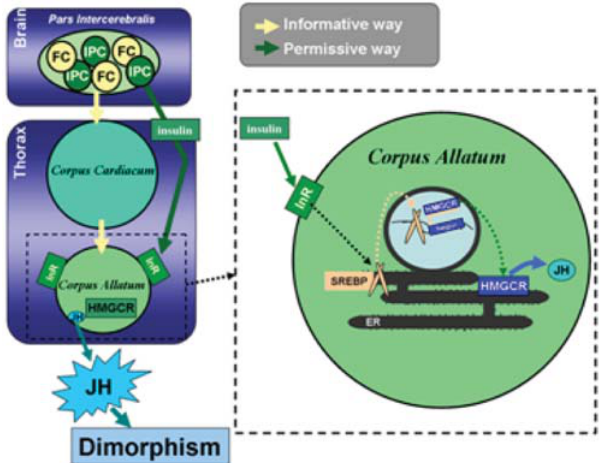
Figure 8. Model of the insulin pathway regulating the expression of the HMGCR in the corpus allatum. We hypothesize that the two different populations of cells, the Insulin Producing Cells (IPCs) and the feminising cells (FCs), located in the pars intercerebralis control, by two distinct ways, the JH synthesis/release by the corpus allatum . The informative way (in yellow), which could be feminised, might control the level or the timing of the JH release, while the permissive way (in green) might control or allow the presence of the molecular machinery, as the transcription of the HMGCR, to promote the JH synthesis. In magnification: in the corpus allatum, insulin binds to its receptor (InR), which activates SREBP. In turn, SREBP regulates the transcription of hmgcr